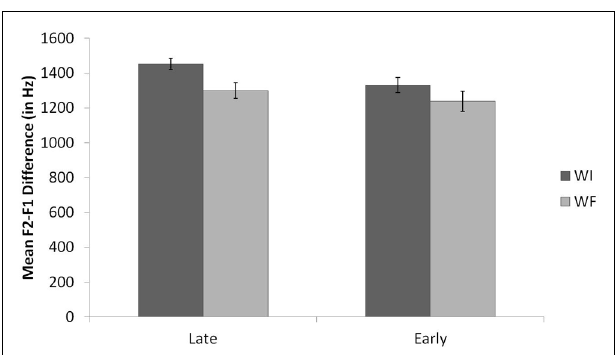
FIGURE 4 | Mean raw F2-F1 values by context for Late Bilinguals and Early Bilinguals for Spanish. Error bars refer to standard